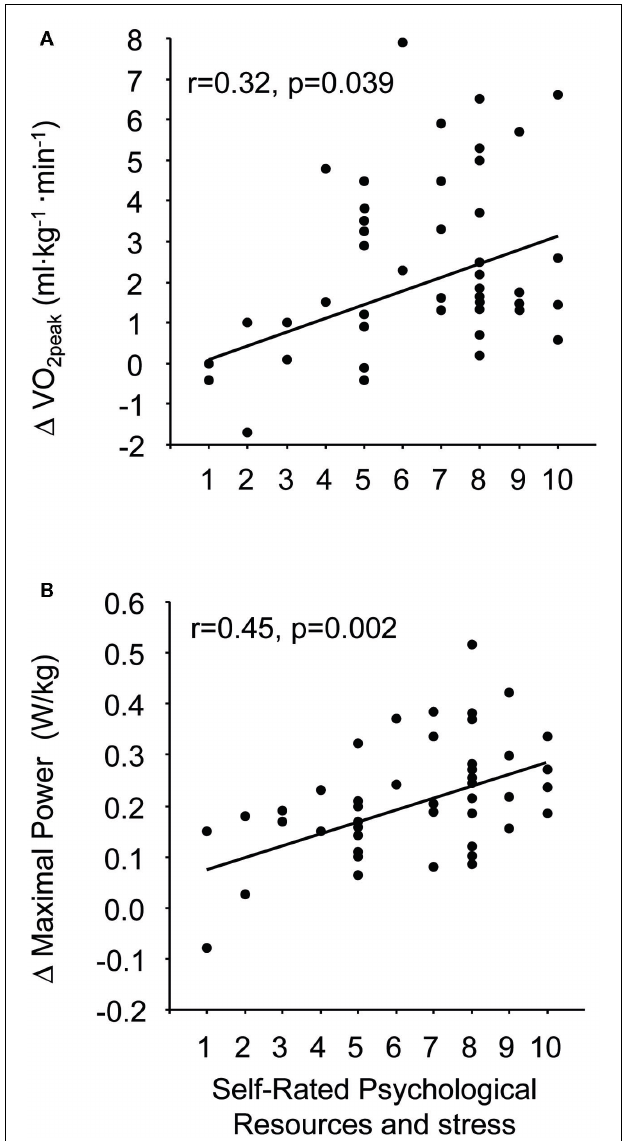
FIGURE 1 |The association between the self-rated psychological resources and stress from 1 (low psychological resources and a lot of stressors in my life) to 10 (high psychological resources and no stressors in my life, respective) and the change in V O change in maximal power